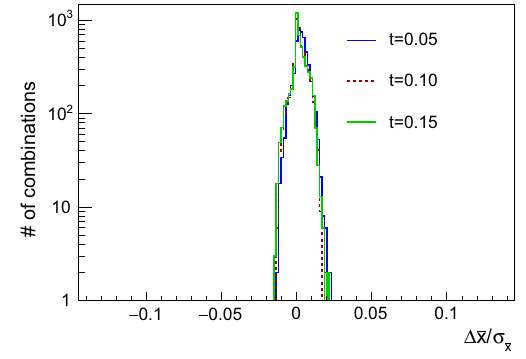
Fig. 12 Difference between the combined results neglecting correla- tions between uncertainties within a measurement and using a direct likelihood combination relative to the total uncertainty on ¯ x . The distri- bution is shown for different values of the upper threshold for system- atic uncertainties t . For comparison with the method proposed here, see Figs. 3 and 4